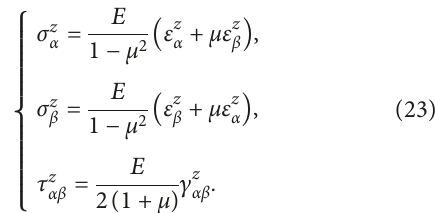
Figure 17: Comparisons of energy parameters under different intensities. (a) Intensity of 1500kg TNTequivalent mass explosion: (i) KE (ii) EPT. (b) Intensity of 380kg TNT equivalent mass explosion: (i) KE max ; (ii)